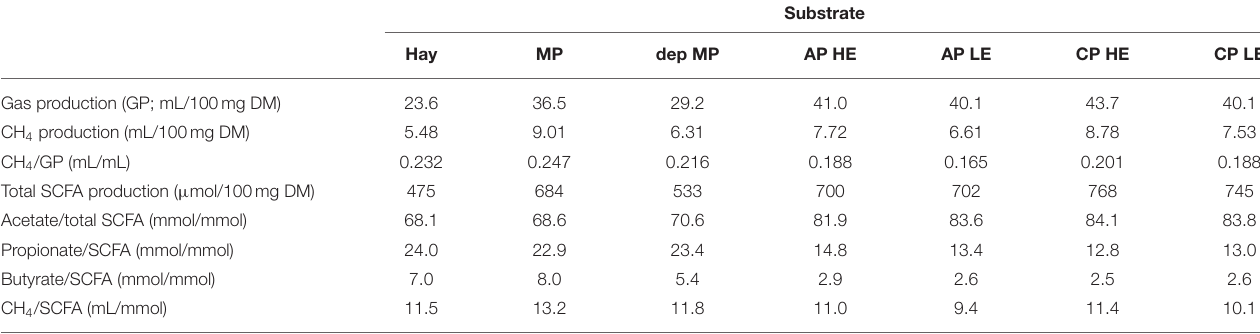
TABLE 2 | Total gas, methane (CH 4 ) and short-chain fatty acid (SCFA) productions of pectic substrates after 24h in vitro incubation [adapted from Geerkens et al. (114)]. Substrate Hay